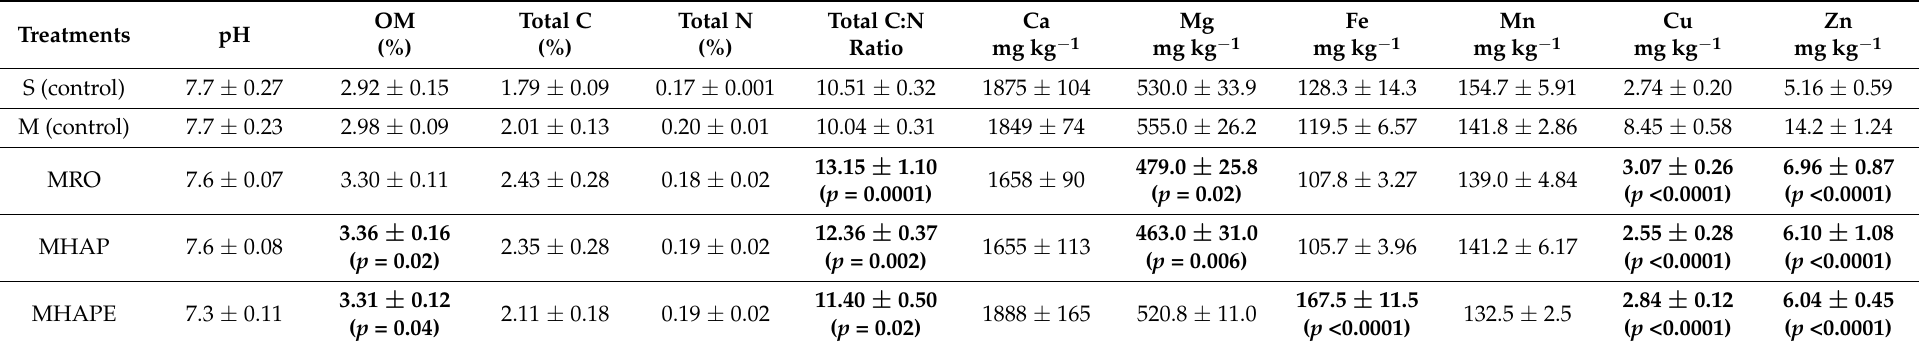
Table 3. Comparison between different treatments on corn soil physicochemical properties and Mehlich3 (M3) extractable nutrients in pot study experiments. Values are given in mean +/ − standard deviation for n = 4 replicates. Values in parentheses represent p -values at 0.05 level, while bold values signify statistical significance to manure treatment (M).